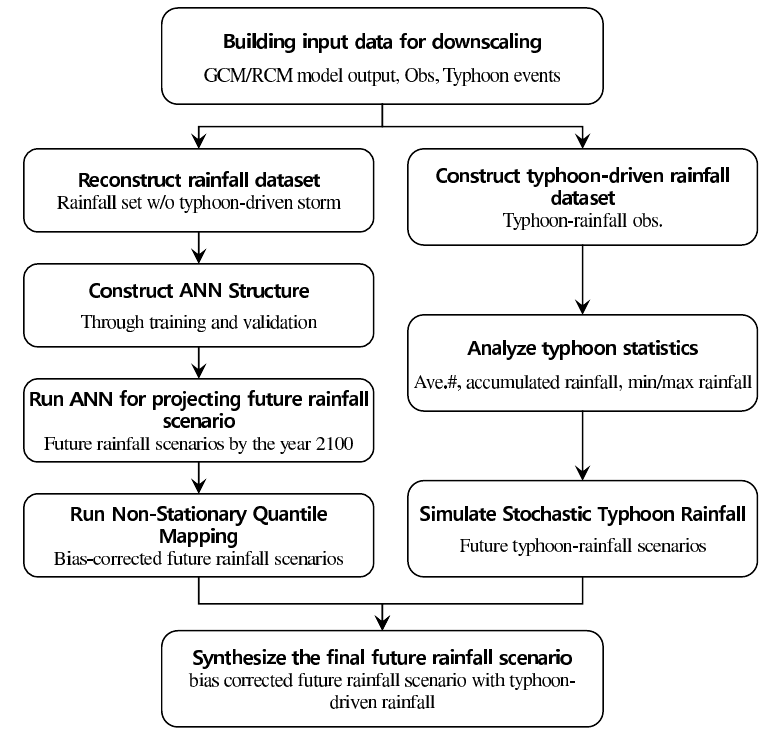
Figure 3. Schematic diagram for the statistical composite downscaling